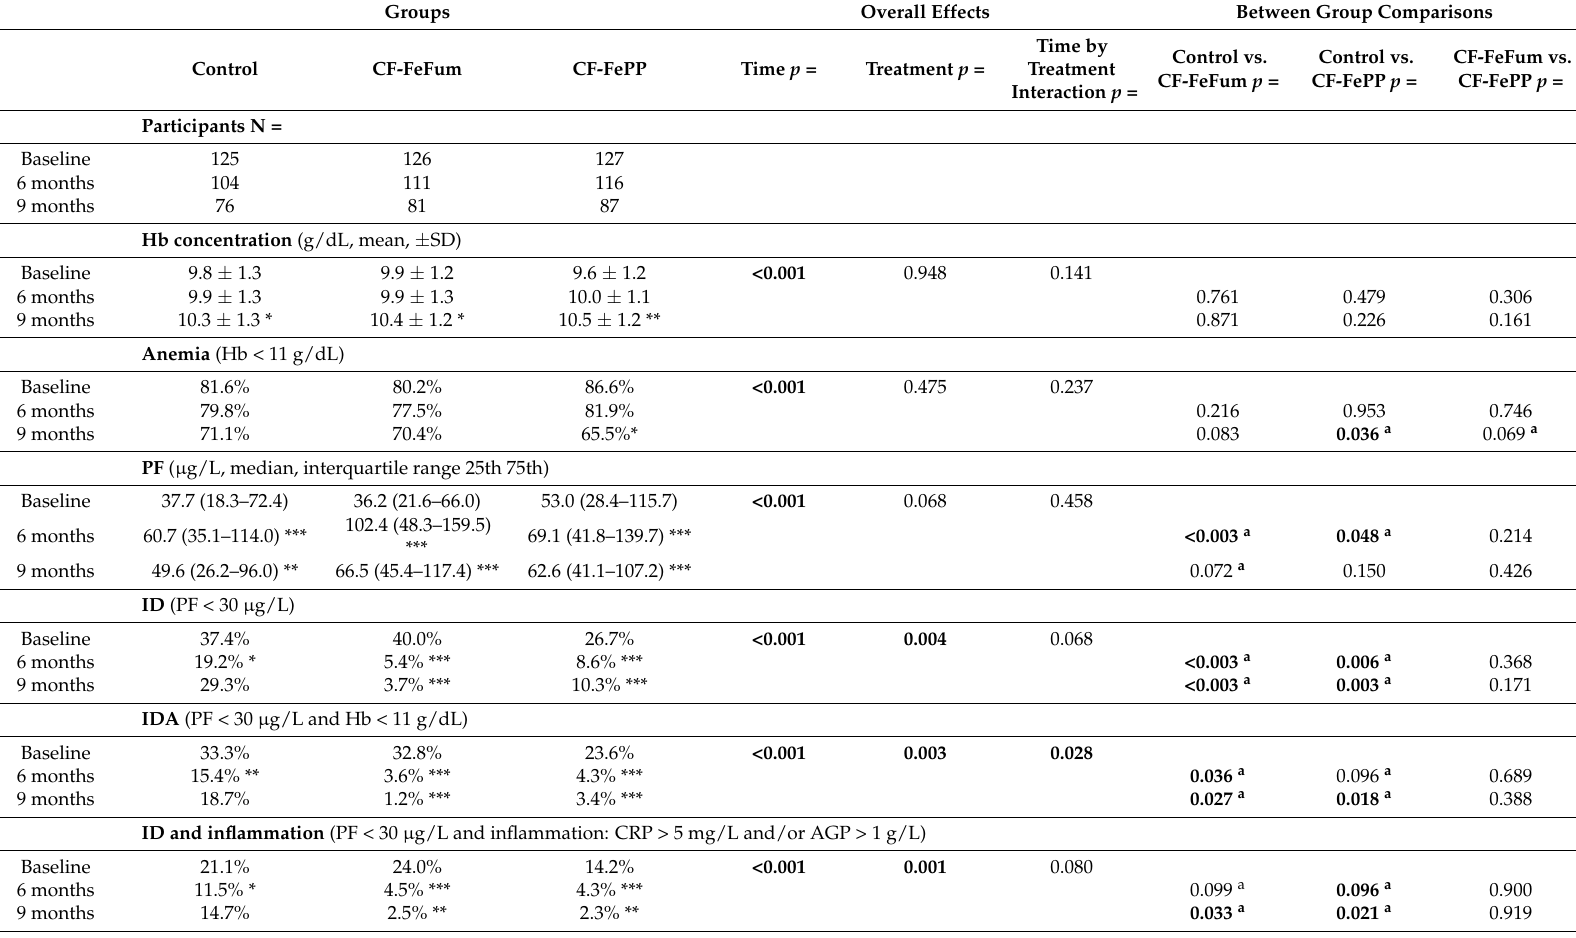
Table 2. Hemoglobin (Hb) concentration and iron status biomarkers at baseline, six months, and nine months in 12- to 36-month-old Ivorian children in the control group and in children consuming iron fortified complementary food (CF) containing NaFeEDTA combined with either ferrous fumarate (FeFum) or ferric pyrophosphate